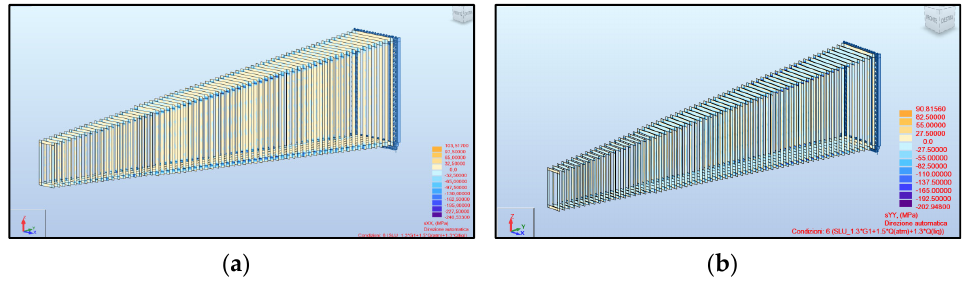
Figure 12. Transversal stiffening members stress path: ( a ) UC σ x; ( b ) UC σ y.